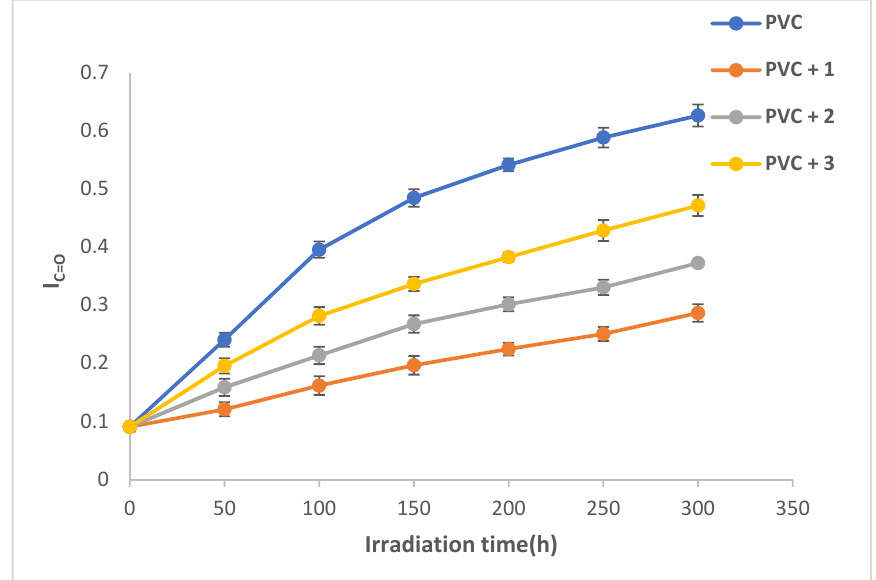
Figure 2. Irradiation time against I C=O index alternations of PVC.